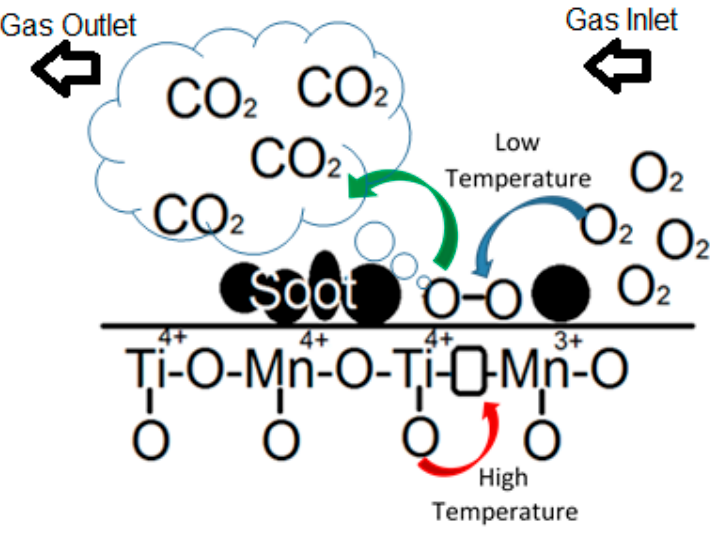
Figure 6. Scheme of soot catalytic oxidation over Mn doped SrTiO 3 catalyst.